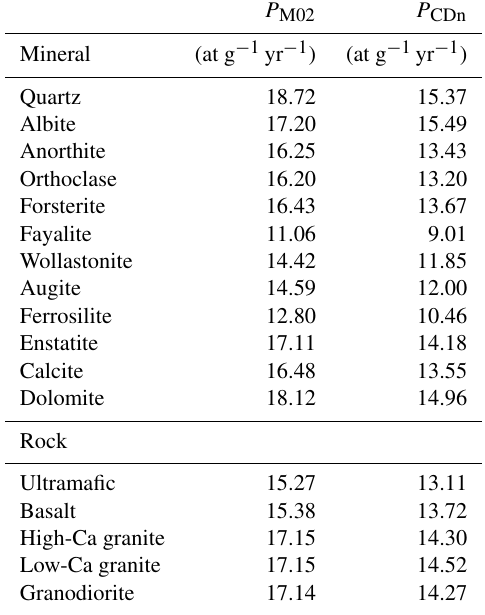
Table 5. Neutron-only SLHL in situ 14 C production based on Masarik’s (2002; P M02 ) theoretical predictions for compositions considered in this work, compared to modern SLHL neutron-only production predicted here (also see Table 2). Note that these esti- mates are not normalized relative to P Qcal to enable direct compar- ison to Masarik’s (2002)